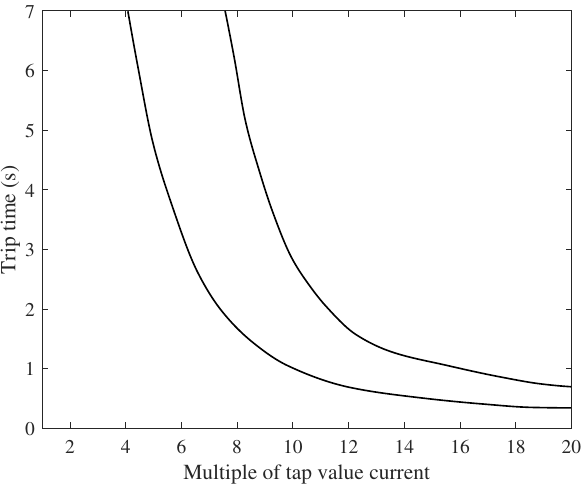
Figure 11. Examples of time-overcurrent relay curves